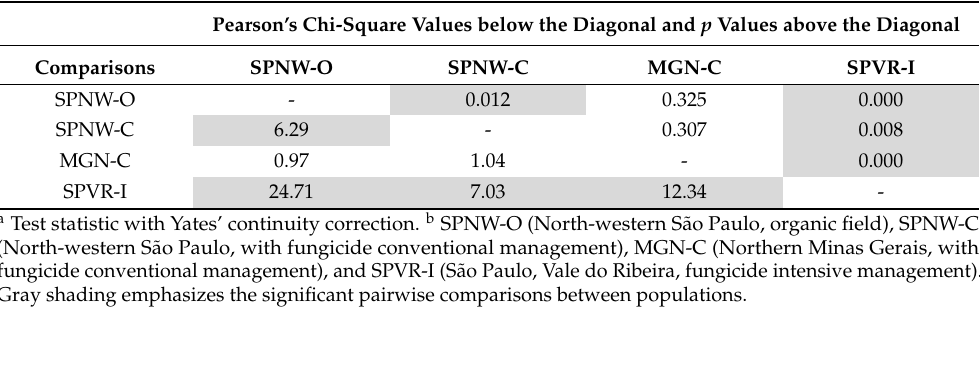
Table 3. The two-proportions z-test based on Pearson’s Chi-square used to compare the equality of two observed proportions of QoI resistant isolates from populations of Mycosphaerella musicola , M. fijiensis , and M. thailandica from banana plantations under distinct fungicide management a, b .